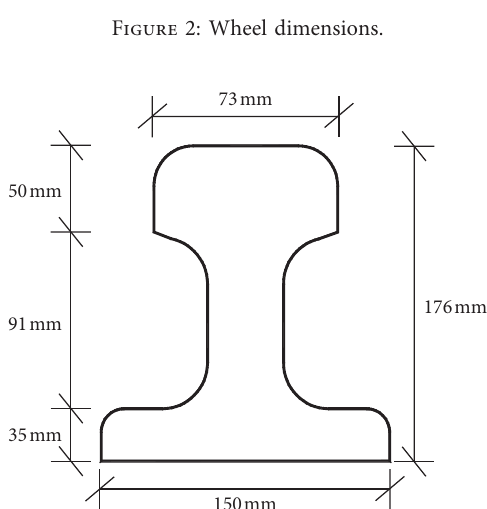
Figure 2: Wheel dimensions.